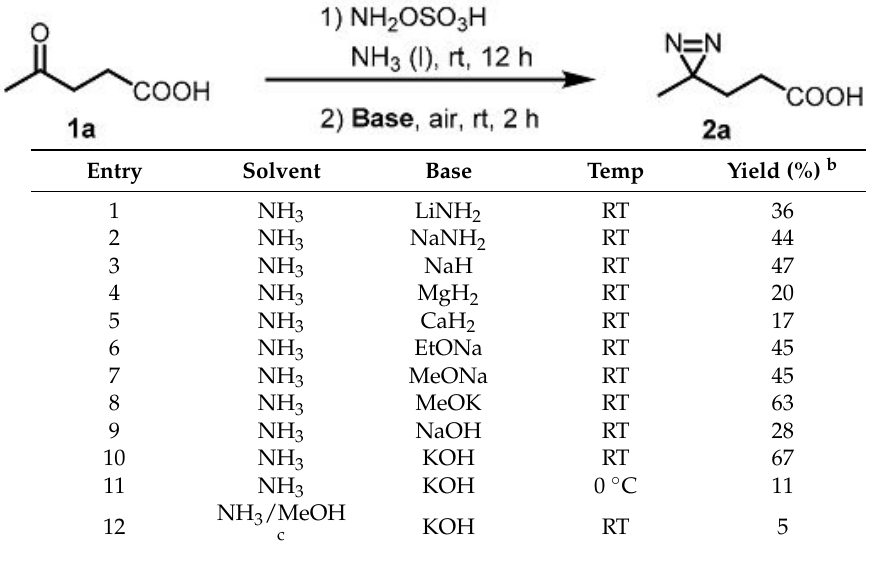
Table 1. Reaction optimization of one-pot synthesis for aliphatic diazirine 2a a